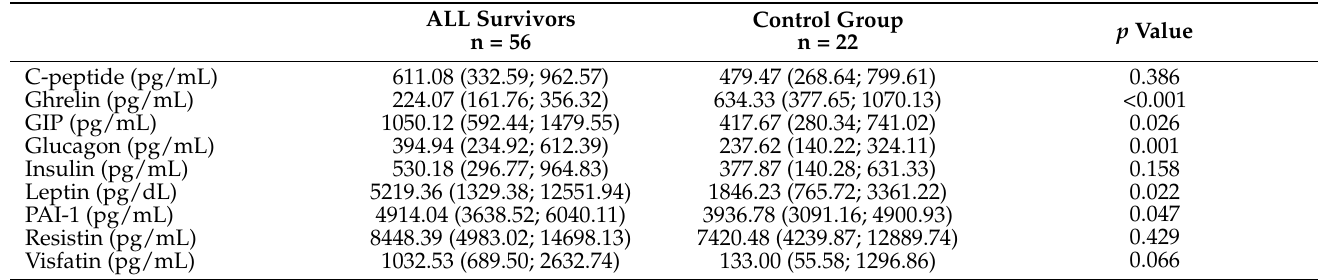
Table 3. Comparison of diabetes marker concentrations between the ALL survivors and the con- trol